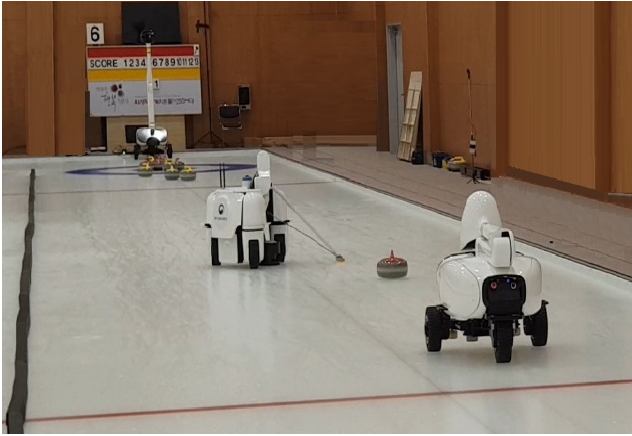
Figure 11. Experiment on creating a return path using the return path algorithm in an actual curling field.